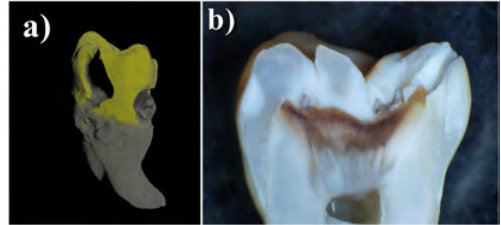
Figure 2. a) 3D model of the damaged tooth by caries from micro-CT (SkyScan 1272, Bruker, Belgium); b) The longitudinal cross section of a tooth with tooth decay in the enamel and dentin (optical microscope Olympus, SMZ 2MT,